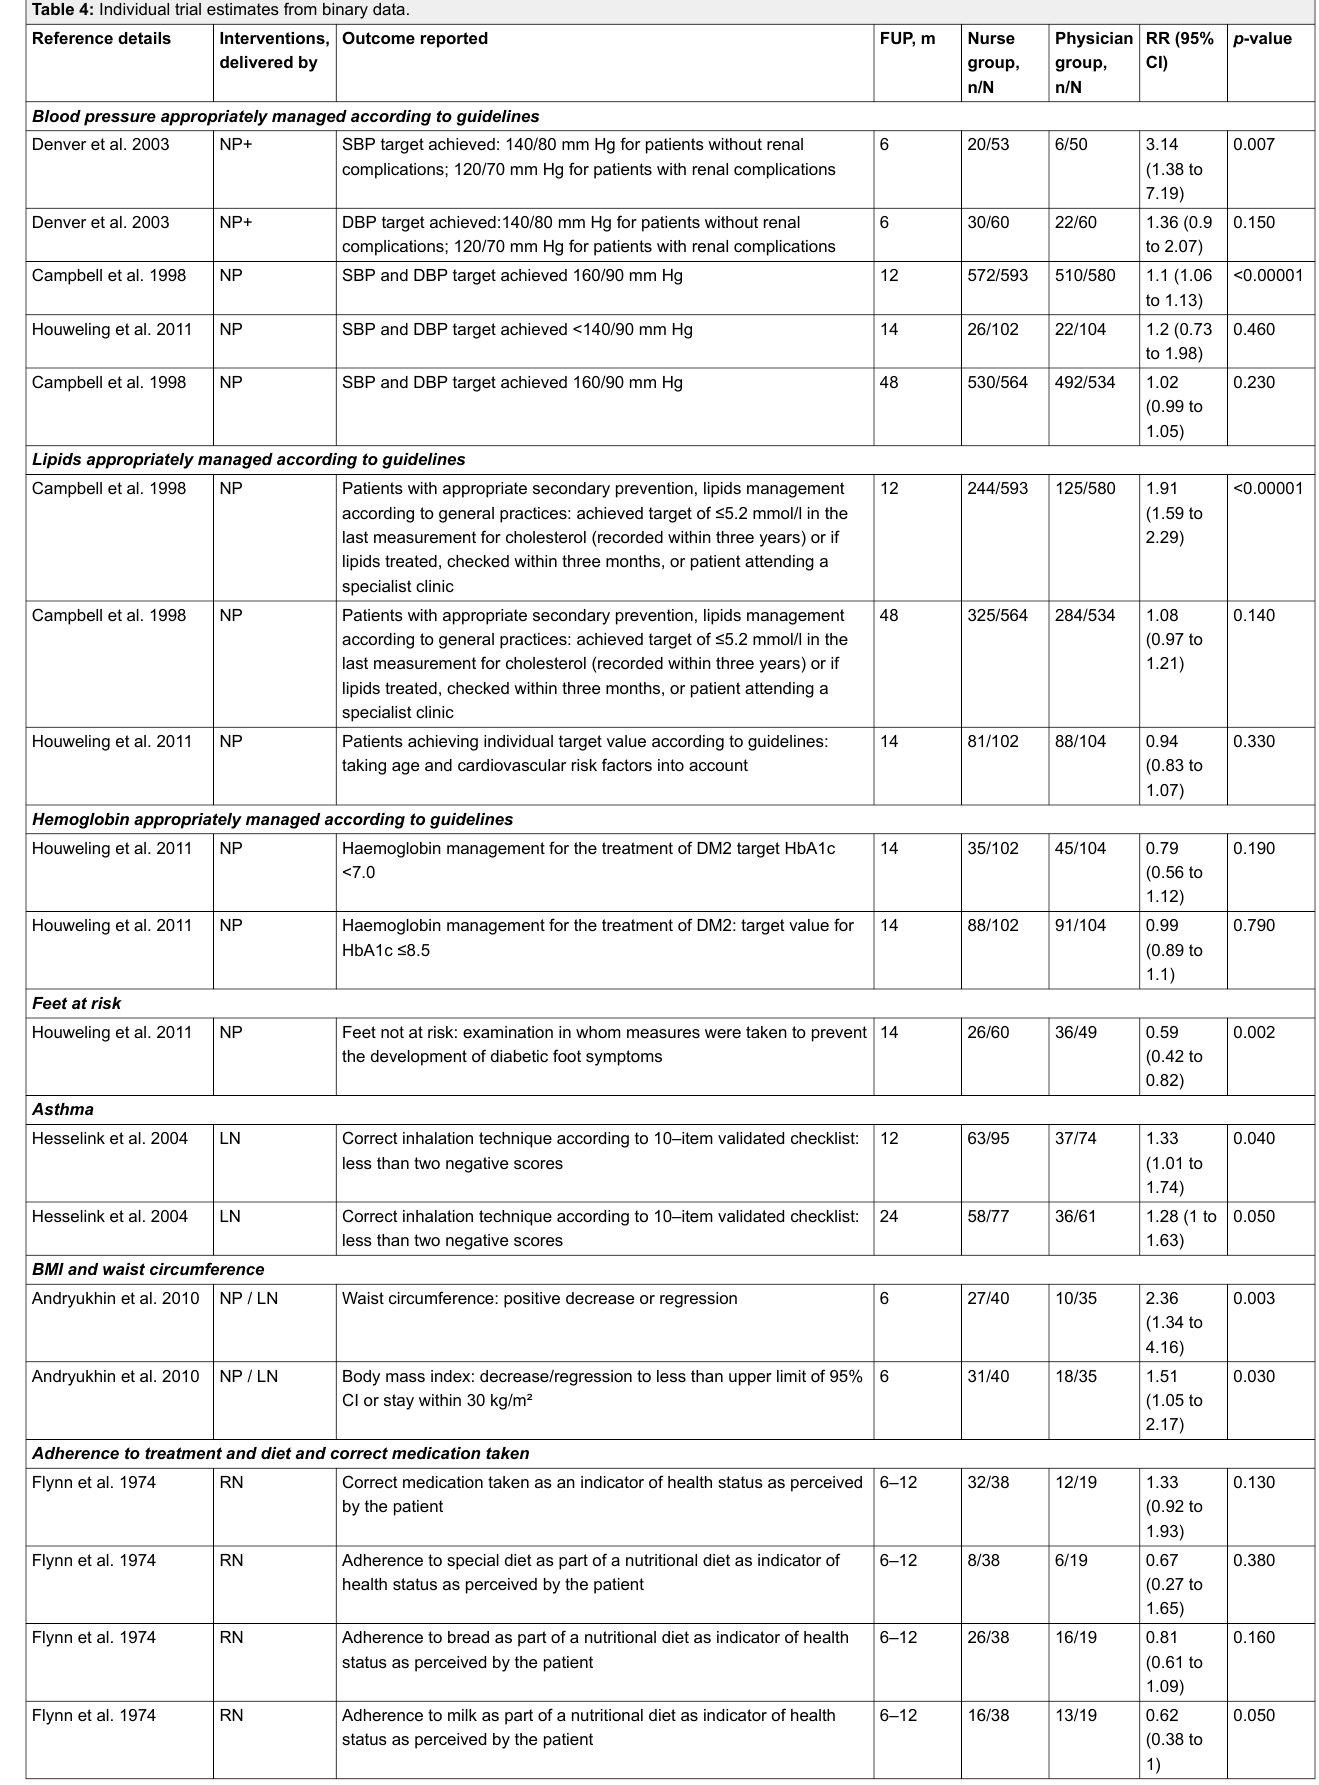
Table 4: Individual trial estimates from binary